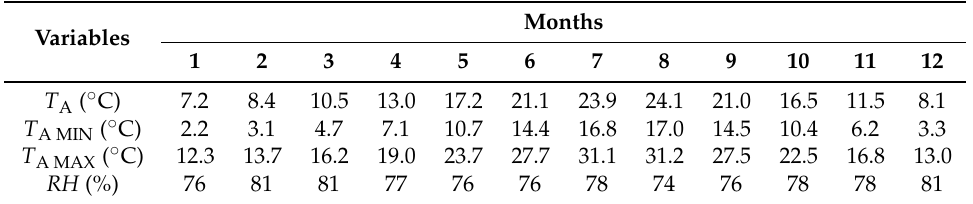
Table 1. Average values of the air temperature and relative humidity in Rome